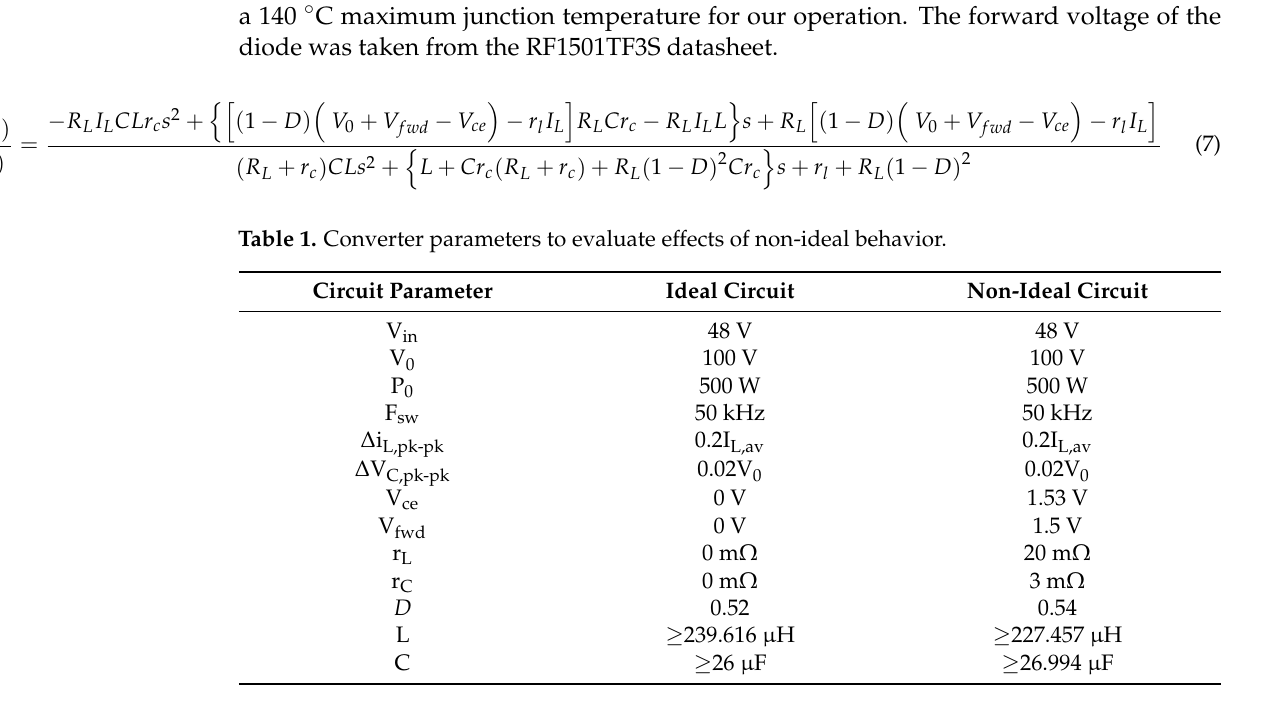
Figure 10. Bode plot showing error incurred when non-ideal characteristics are ignored.